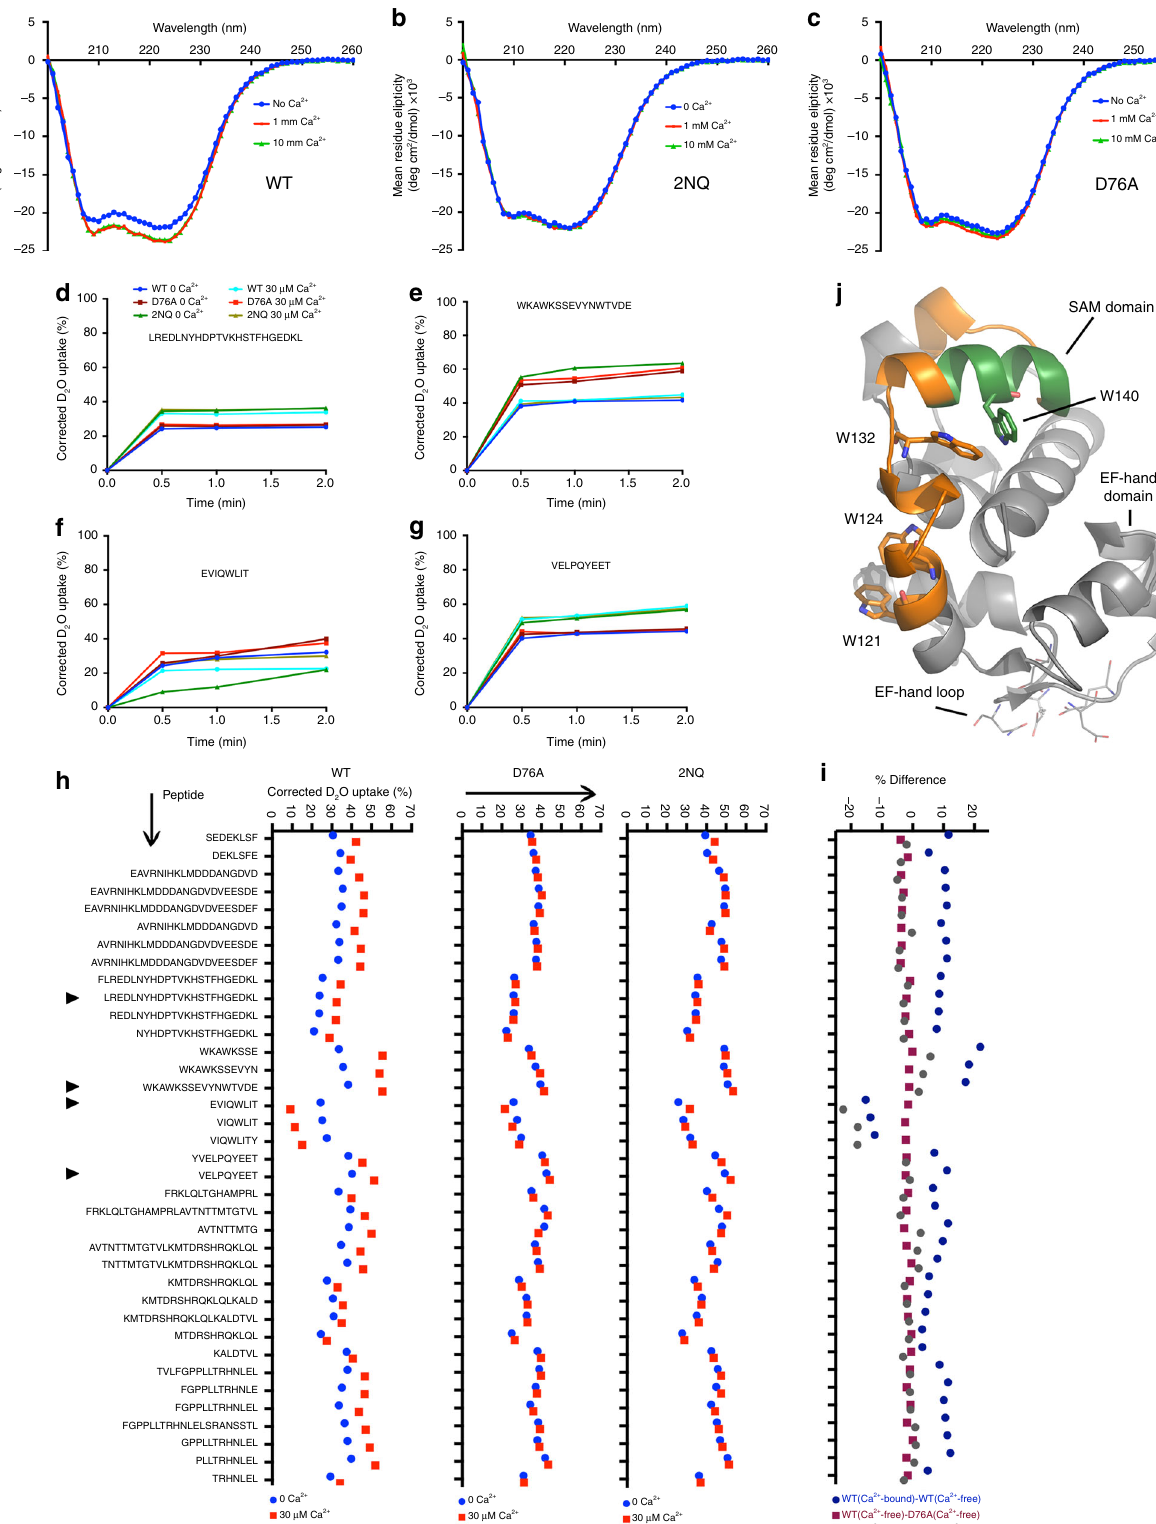
domains in cells by their linkage to the STIM1 transmembrane concentrations occupies multiple sites in the EFSAM domain, helices and the dimeric STIM1 cytoplasmic domain. We show not solely the EF-hand site; and that the additional EFSAM here that Ca 2 + dissociation from EFSAM-GrpE or from full- Ca 2 + -binding sites are required together with the EF-hand site to length STIM1 controls a switch between two structured con- control physiological activation of STIM1 in cells. We show formations of the EFSAM domain; that Ca 2 + at physiological further that Ca 2 + binding at the EF-hand and Ca 2 + binding at NATURE COMMUNICATIONS| (2018) 9:4536 |DOI: